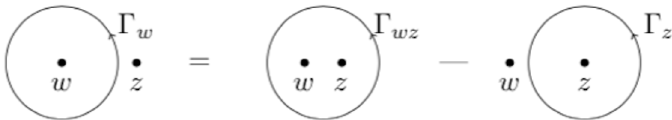
Figure 1 . Rearrangement of integral contour for the OPE